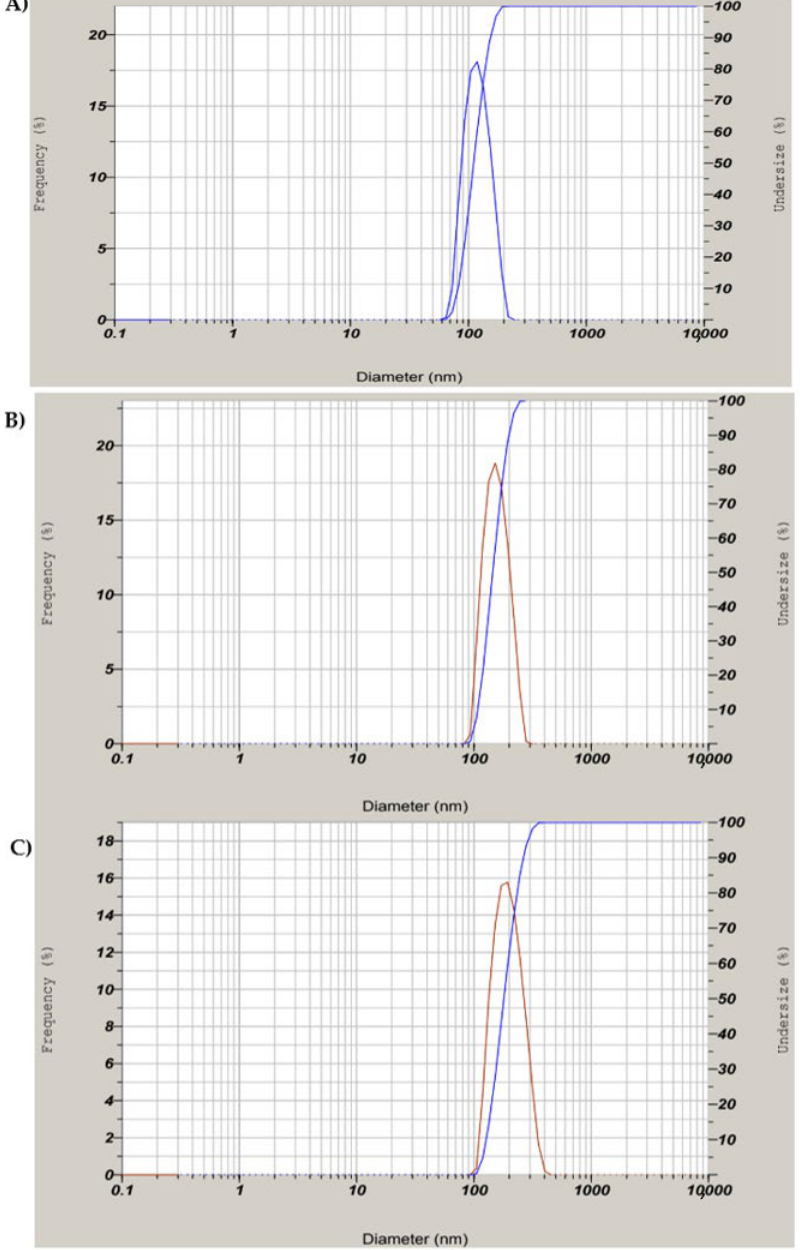
Figure 6. DLS analysis for ( A ) biosynthesized SeNPs using seed extract, ( B ) SeNPs modified with chitosan ( C ) PTX-loaded chitosan-modified SeNPs.